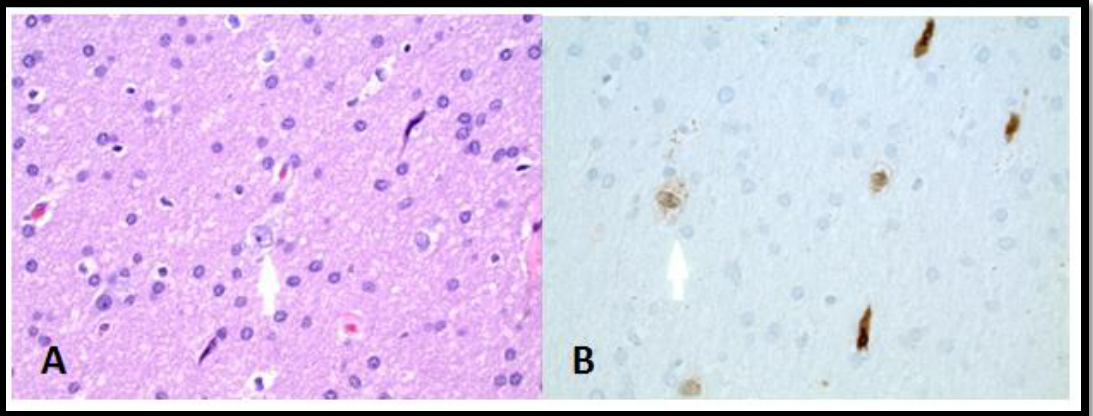
Figure 3. Histology of the resected left temporal lobe tissues. ( A ) Heterotopic white matter neurons HE stain × 400. ( B ) Heterotopic white matter neurons (5 in the field) highlighted by NeuN immunostain × 400.